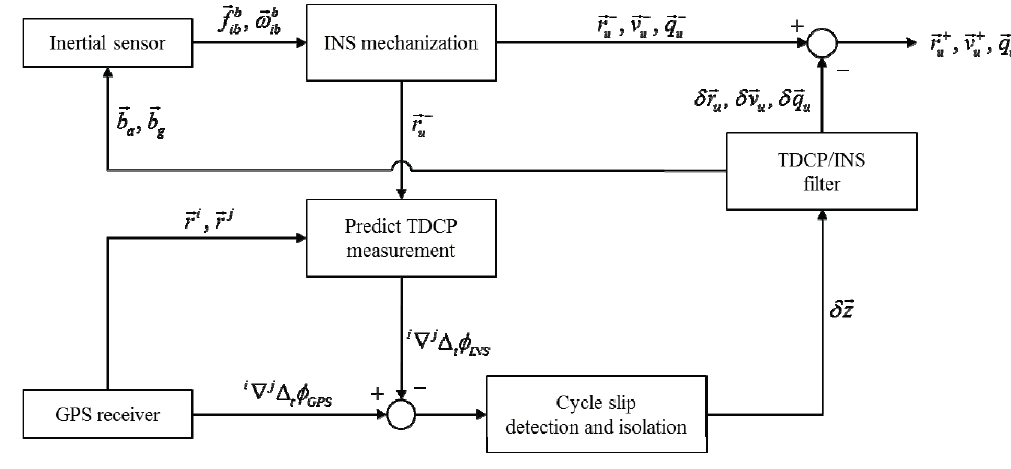
Figure 6. Tightly coupled TDCP/INS